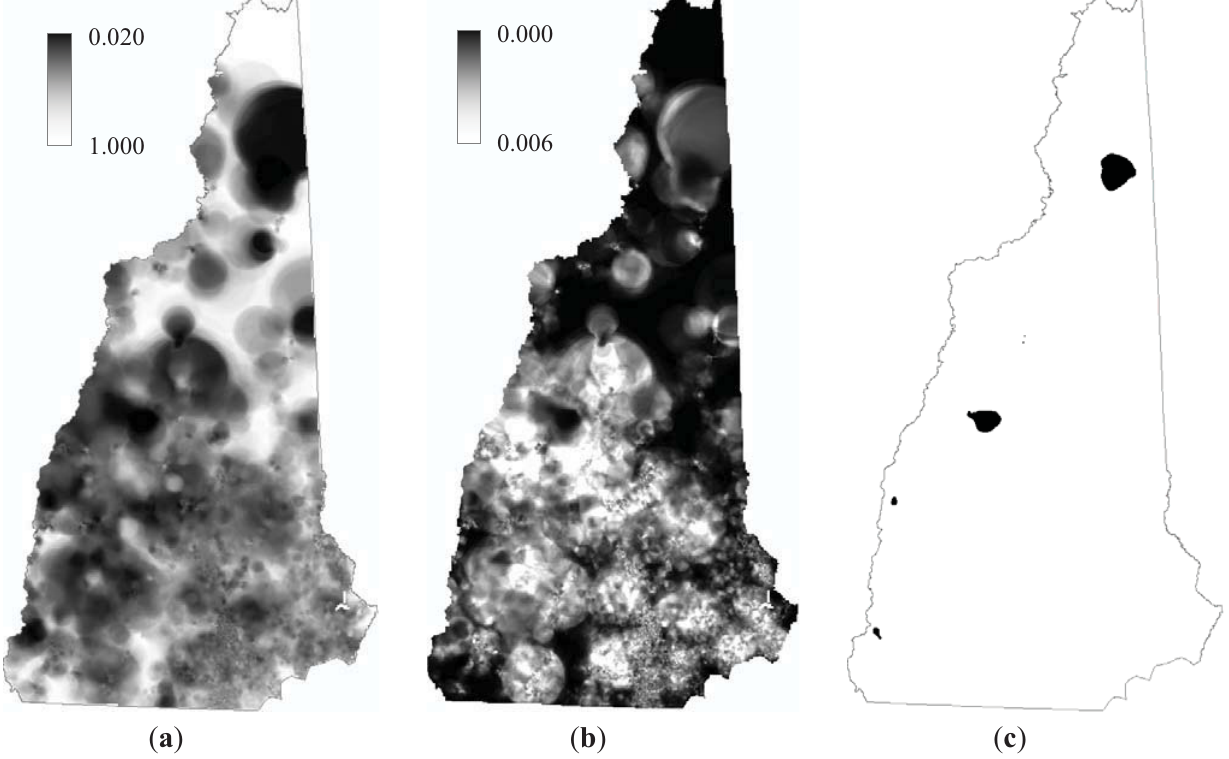
Figure 4. Mapping the birth defects in New Hampshire, 2003–2009. ( a ) Map of